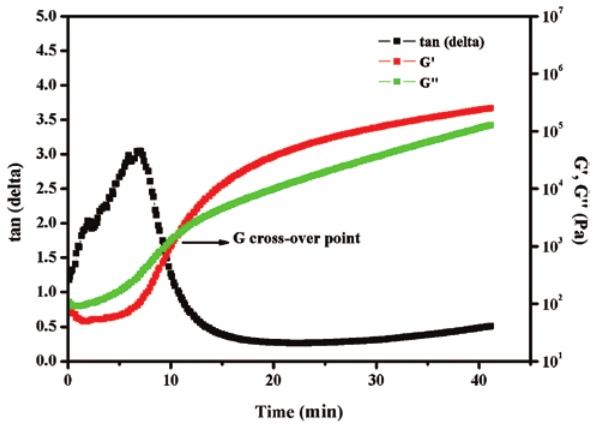
Figure 6: Time vs. viscosity curves with 10% BAPh/PEN-OH pre- polymers at 200 °